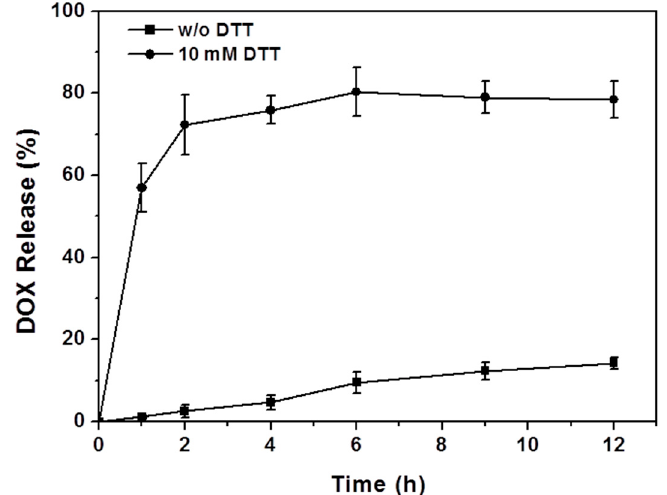
Figure 7. In vitro release of doxorubicin (DOX) from DOX-loaded micelles in phosphate buffered saline (PBS) at 37 °C without (w/o) or with 10 mM DL -dithiothreitol (DTT) treatment. Data are mean ± standard deviation (SD), n = 3.